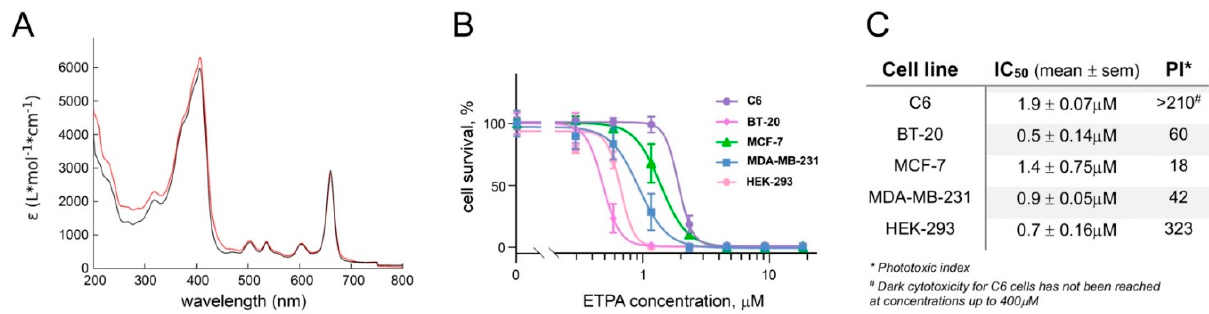
Figure 2. ( A ) Absorbance spectra of the chlorin compound isolated from the butanol fraction of the EtOH extract from control (red) and fasted (black) O. sarsii reveal absorbance peaks typical for chlorins, identical between the two preparations; ( B ) cell survival (MTT test) to evaluate the strong phototoxicity of ETPA after red-light irradiation. Data are given as mean ± SEM, n = 8 (3 for HEK-293 cells); ( C ) ETPA phototoxicity IC 50 and the phototoxicity index (PI, calculated as IC 50 in the dark/IC 50 in the light [17]). Cell survival data in the dark are taken from [10] (breast cancer cell lines) or measured separately (C6 and HEK-293 cells, see Supplementary Figure